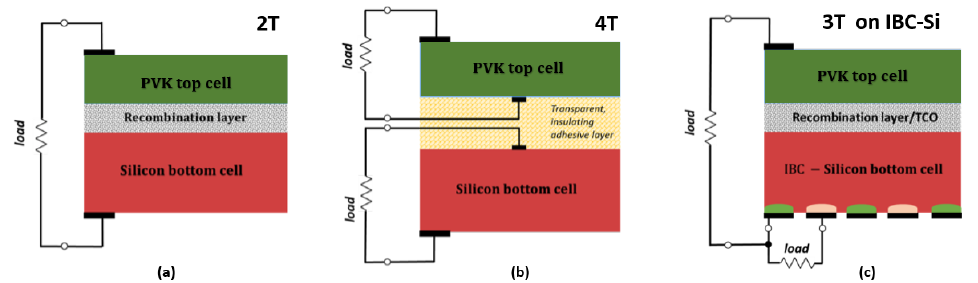
Figure 1. Scheme of PVK/Si tandem solar cells with 2 terminal ( a ), 4 terminal ( b ) and 3 terminal ( c )